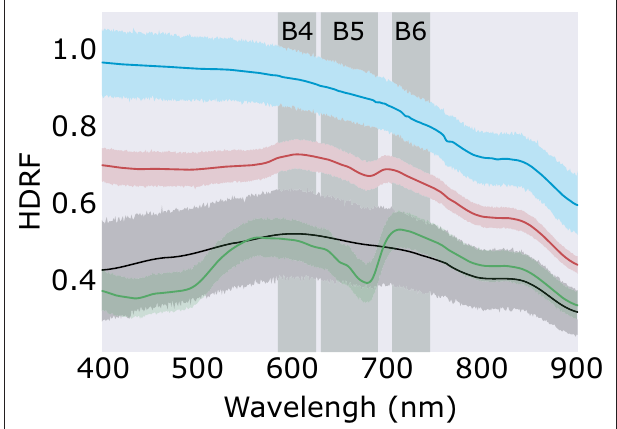
FIGURE 3 | Snow algae reflectance factors. Average hemispherical directional reflectance factors (HDRF) of red snow algae (red; n = 70), green snow algae (green; n = 91), clean snow (blue; n = 38), and mineral dust-entrained snow (black; n = 36). Error band shows the 95% confidence interval. Vertical shaded bands show the position of Bands 4, 5, and 6 of WorldView 3’s multispectral